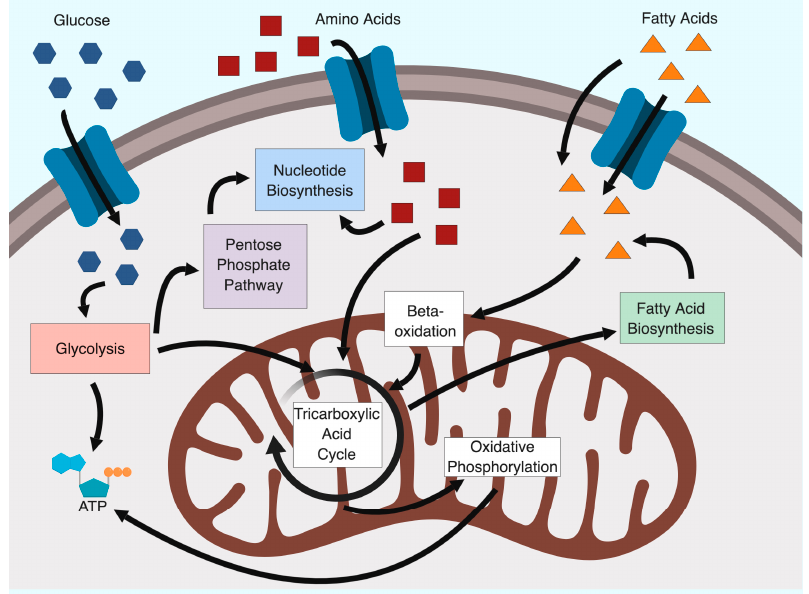
Figure 1. Viruses co-opt many cellular metabolic pathways to satisfy their metabolic requirements. These pathways include those used for energy production, primarily glycolysis and oxidative phosphorylation, and macromolecule production, such as for the synthesis of nucleotides or fatty acids. Created with BioRender.